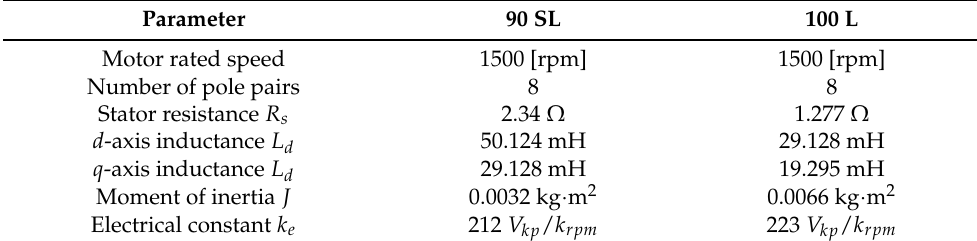
Table 4. Parameters of the PMSMs.